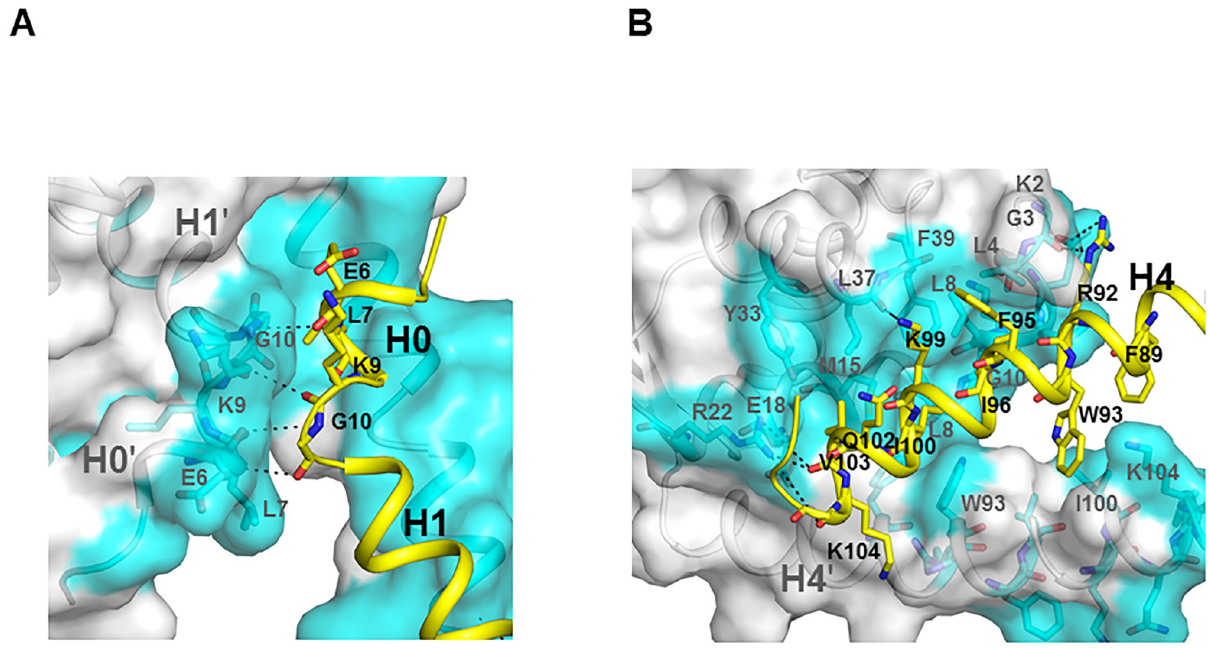
Fig 2. Dimerization contacts of LftR. One LftR subunit is shown as gray ribbons with surface representation, and its dimerization interface residues are highlighted by cyan surfaces and sticks. The other LftR subunit is shown as yellow ribbons, and its dimerization interface residues are depicted as yellow sticks. Hydrogen bonds are represented by dotted lines. (A) Dimerization interface at the N-terminal region of LftR. (B) Dimerization interface generated by the LftR H4 helix.